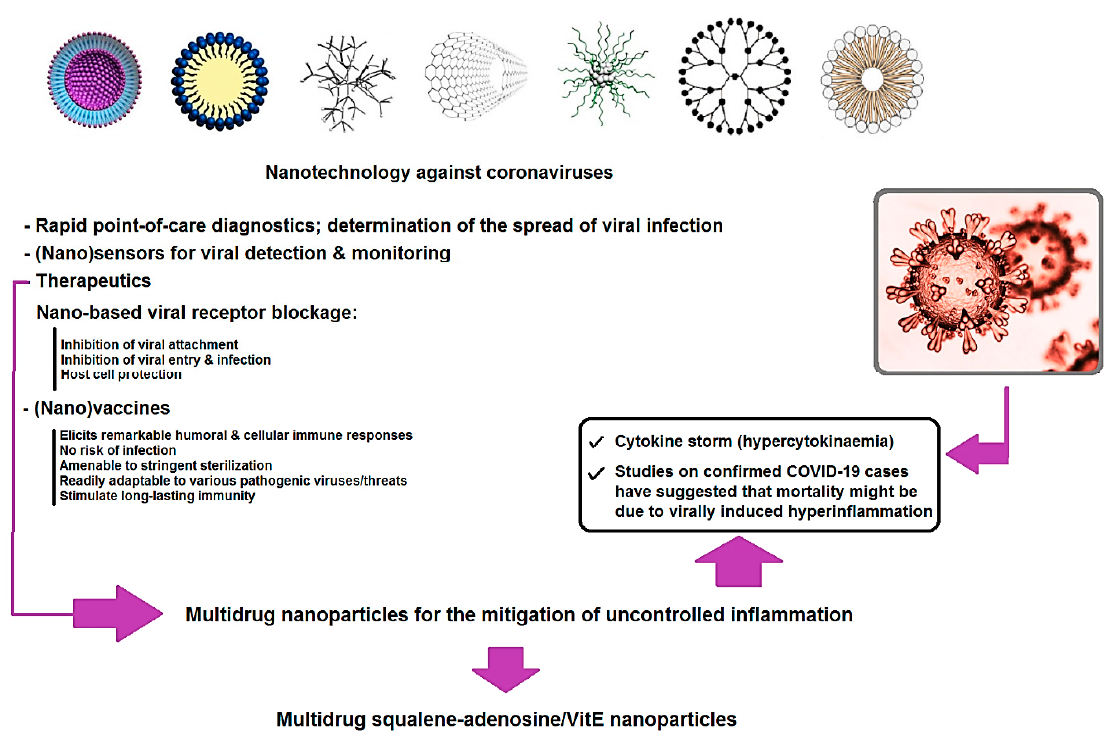
Figure 3. Nano-based approaches against viruses, especially coronaviruses (CoVs).